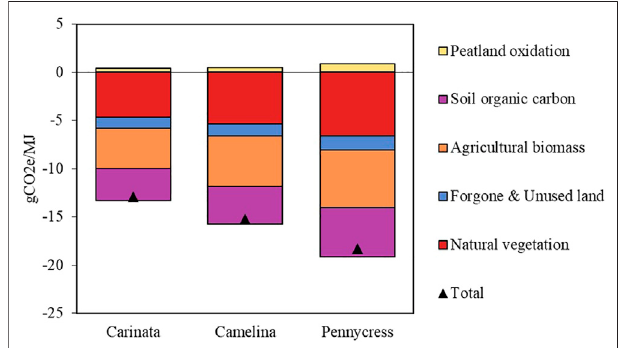
FIGURE 2 | ILUCs for carinata oil, camelina oil, and pennycress in the United States (all by